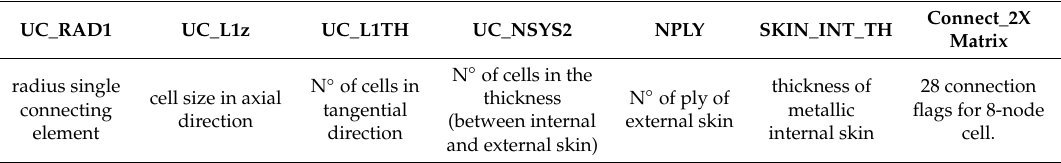
Table 4. Design variables.